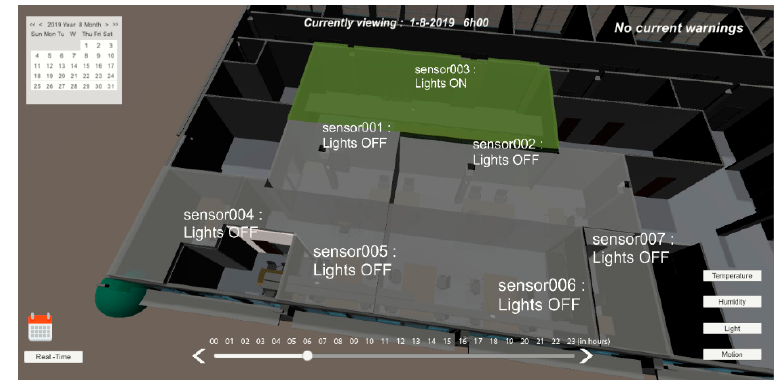
Figure 12. User interface with light mode selected for 01-08-2019 at 06:00 h.